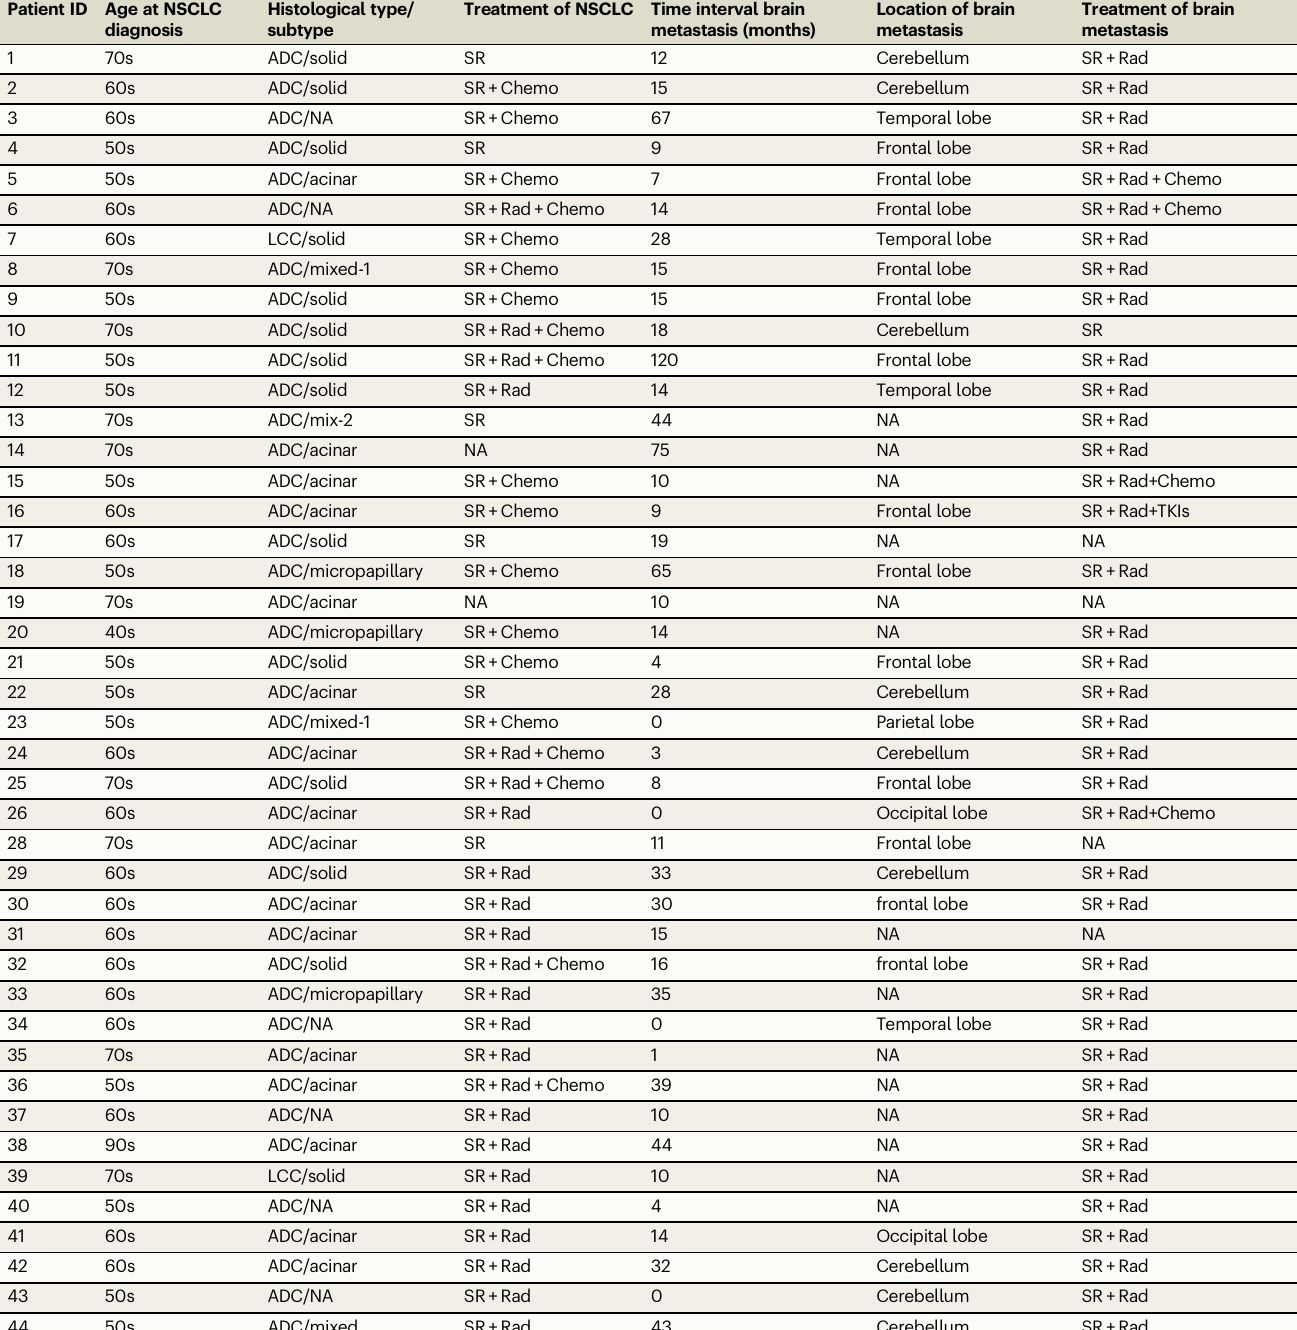
Table 1 | Demographic and clinical information of the patient cohort of this